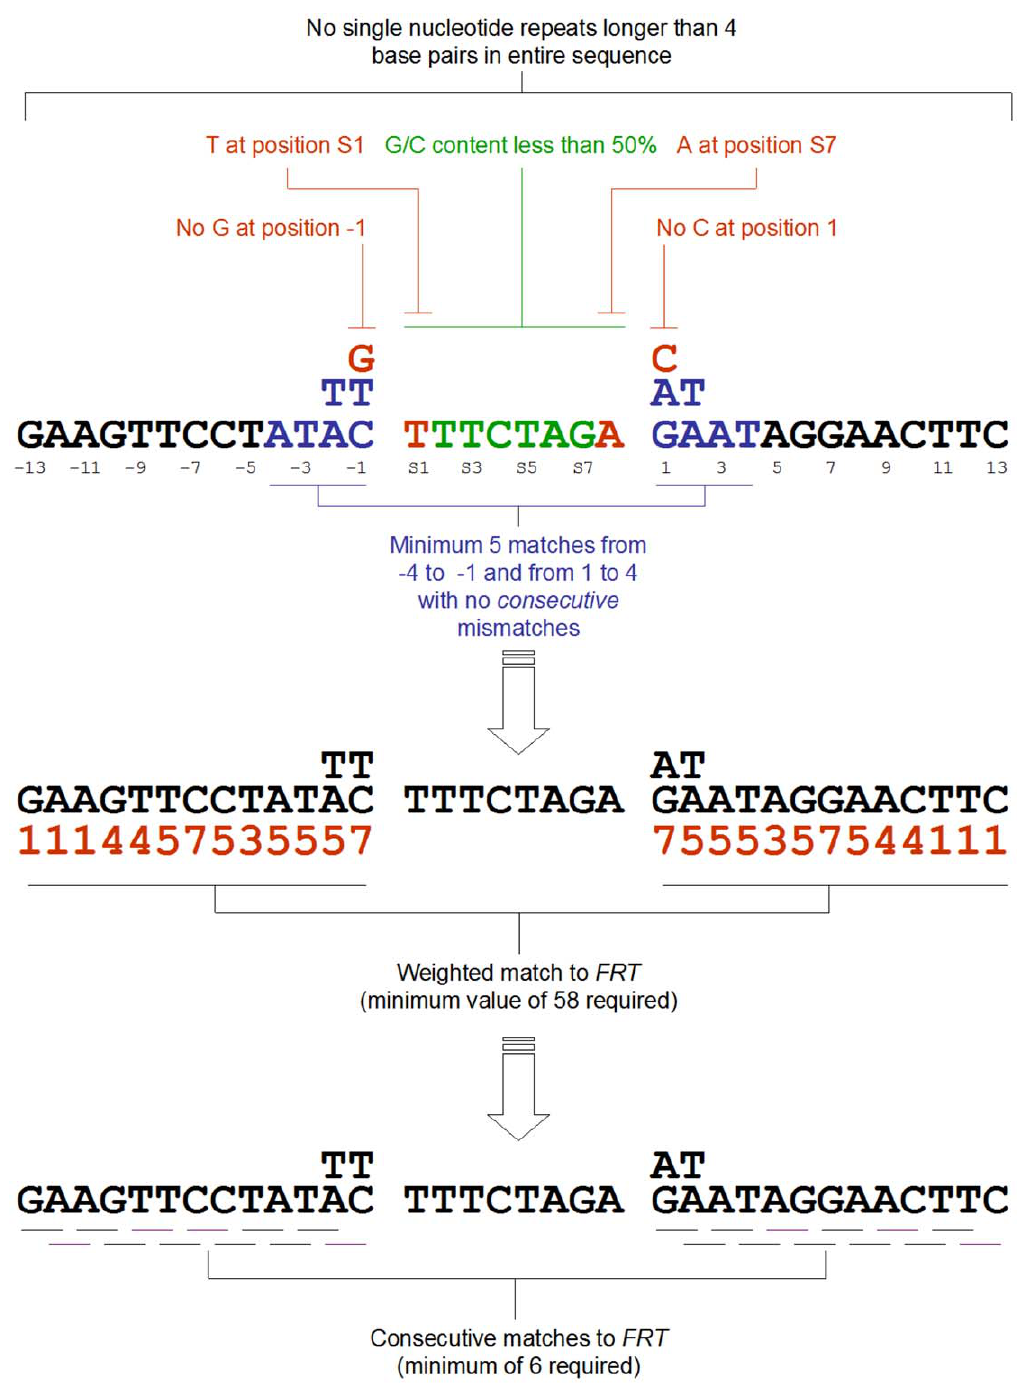
Figure 3. FRT -like sequence identification requirements. See text for details.